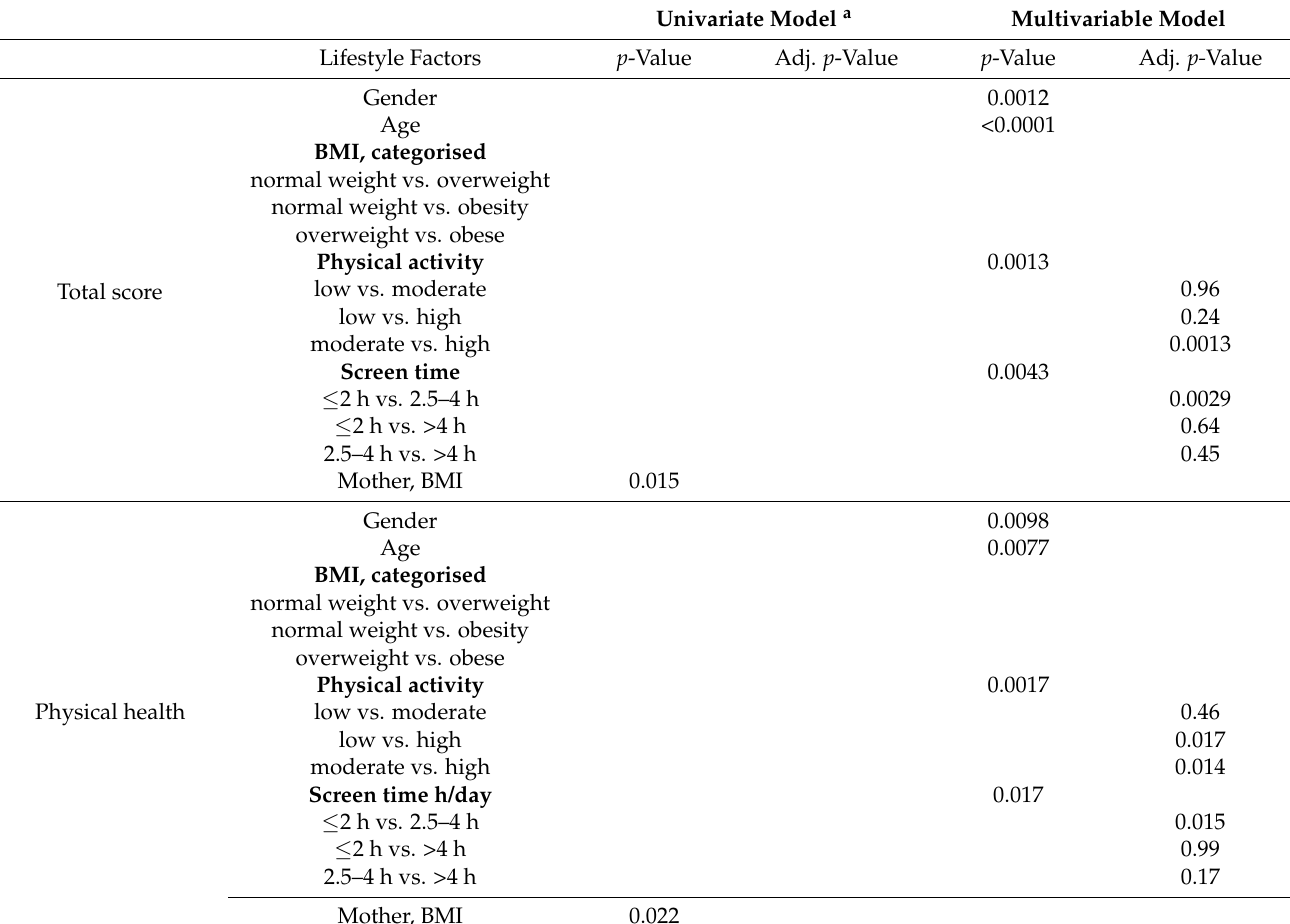
Table 6. Associations between the parental report of PedsQL scores and lifestyle